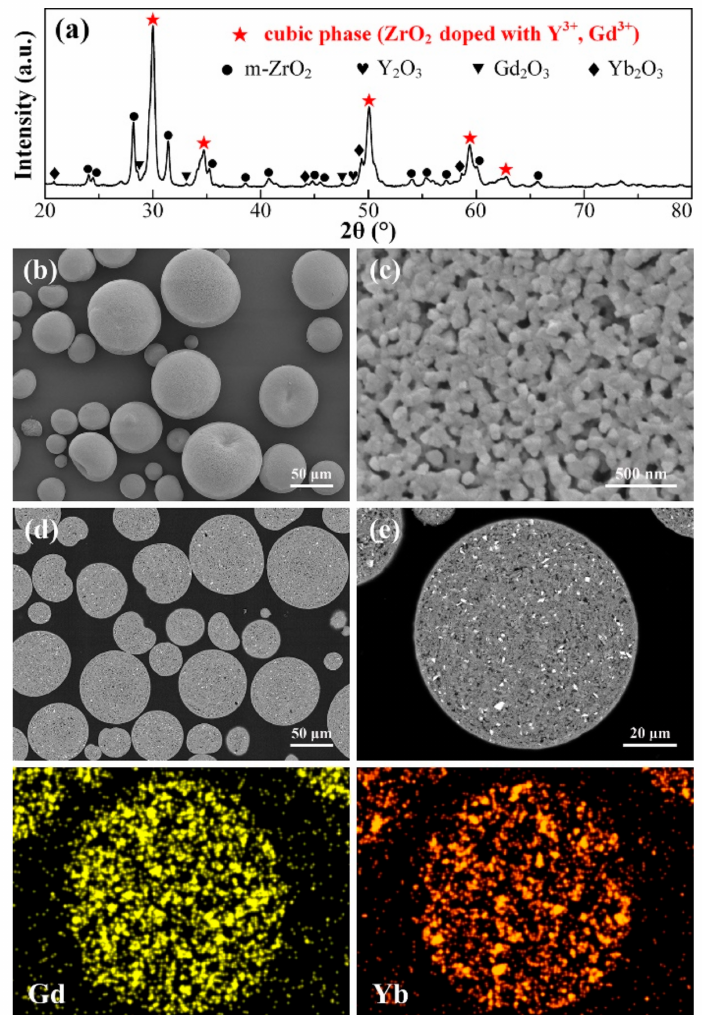
Figure 4. XRD pattern ( a ), surface morphologies ( b , c ) and cross-sectional microstructures ( d , e ) of 10YGYZ agglomerated powders calcined at 1100 ◦ C for 3 h. ( c , e ) are enlarged SEM images of the surface and cross section of a single powder, respectively. Corresponding EDS Gd and Yb maps of ( e ) are also